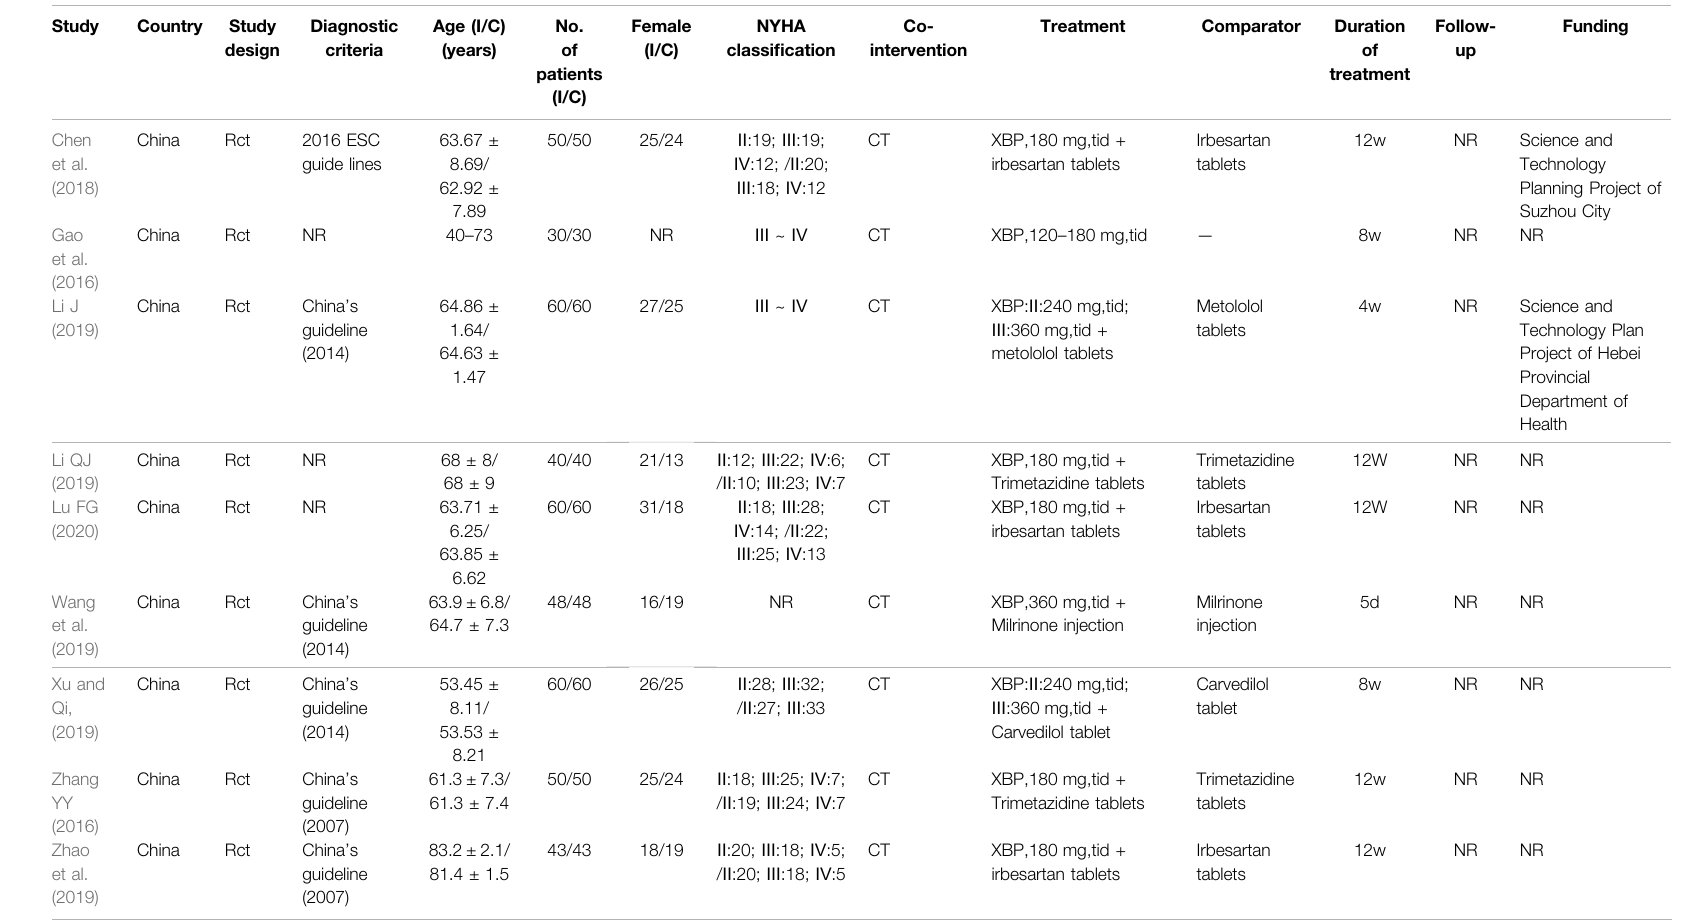
TABLE1 | Characteristics of included